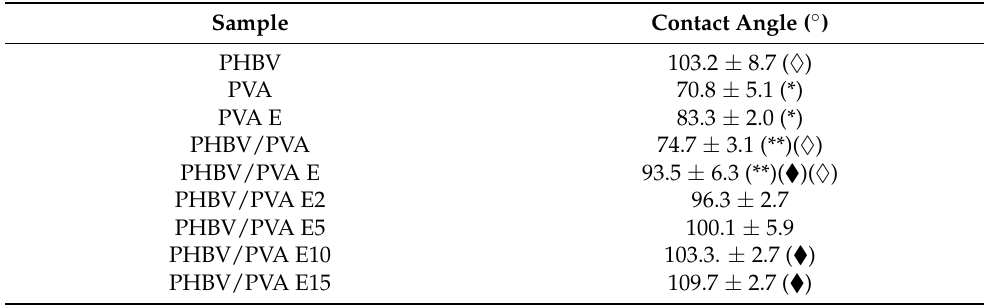
Table 2. Water contact angle measurement of PHBV/PVA blend, semi-IPN and composites with different percentages of PPy nanoparticles. PHBV and PVA (with and without crosslinking) are included as